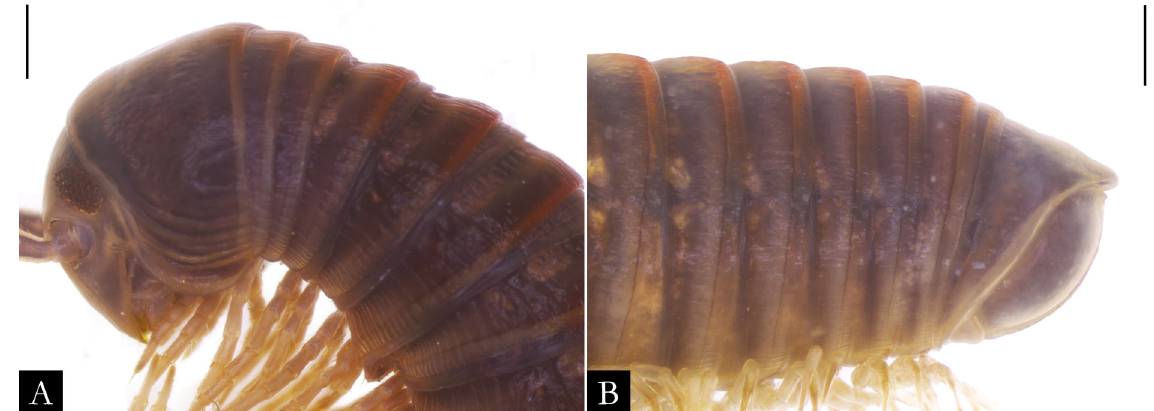
Fig. 153. Pseudonannolene granulata sp. nov., holotype, ♂ (MNRJ), in lateral view. A . Anterior region. B . Posterior region. Scale bars = 1